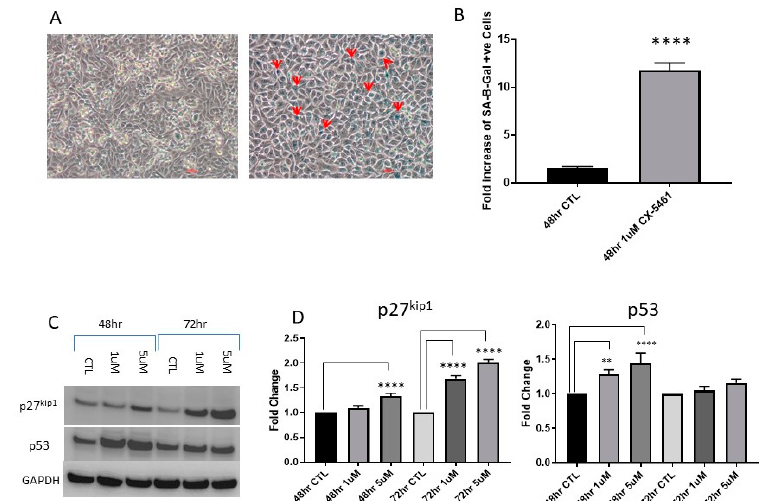
Figure 7. CX-5461 exposure induced cellular senescence. A375 cells where treated with 1 µ M CX-5461 and stained for the presence of B-galactosidase following 48 h CX-461 treatment and imaged using brightfield microscopy ( A ). Cells which have entered into a senescent state are marked by red arrows, (magnification 20 × ). Analysis of blue pixels in treated and untreated samples using ImageJ software showed a significant increase in senescence-associated b-galactosidase-positive cells in CX-5461-treated melanoma cell line ( p -value < 0.0001) ( B ). Western blot analysis of cell-cycle-associated markers p27 kip1 and p53 ( C ), p53 induction could be seen as early as 48 h post CX-5461 treatment ( p -value < 0.0001) in CaSki cell line and strong p27 induction could be observed at 72 h post CX-5461 treatment ( D ). ** = p value < 0.01 and **** = p value < 0.0001.